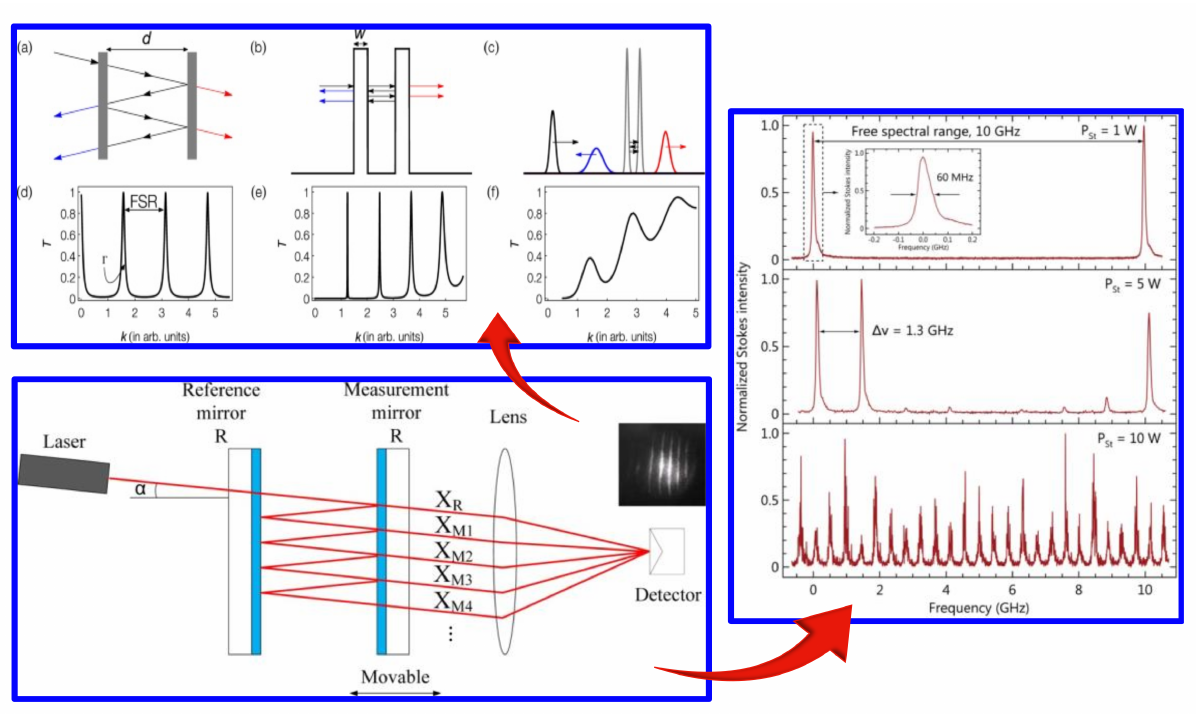
Figure 8. Fabry-Perot interferometers. ( a ) transmission and reflection of narrow-band light, ( b ) narrow-band matter-wave through a rectangular double barrier, ( c ) broad-band Gaussian wavepacket, ( d ), ( e ) and ( f ) correspond to the transmission resonance peaks [193–195].